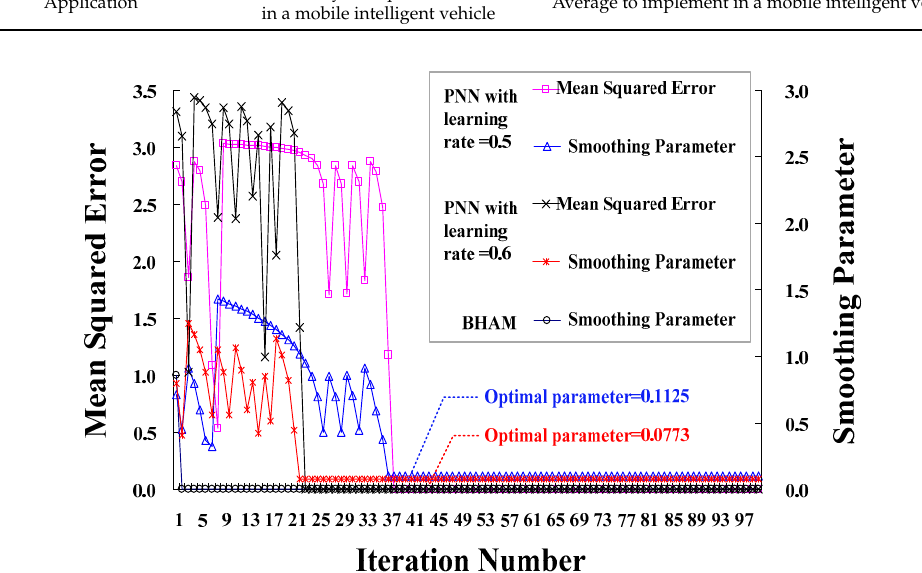
Figure 8. Smoothing parameter and mean squared error versus the iteration number for PNN (learning rate = 0.5 or 0.6) and BHAM methods.